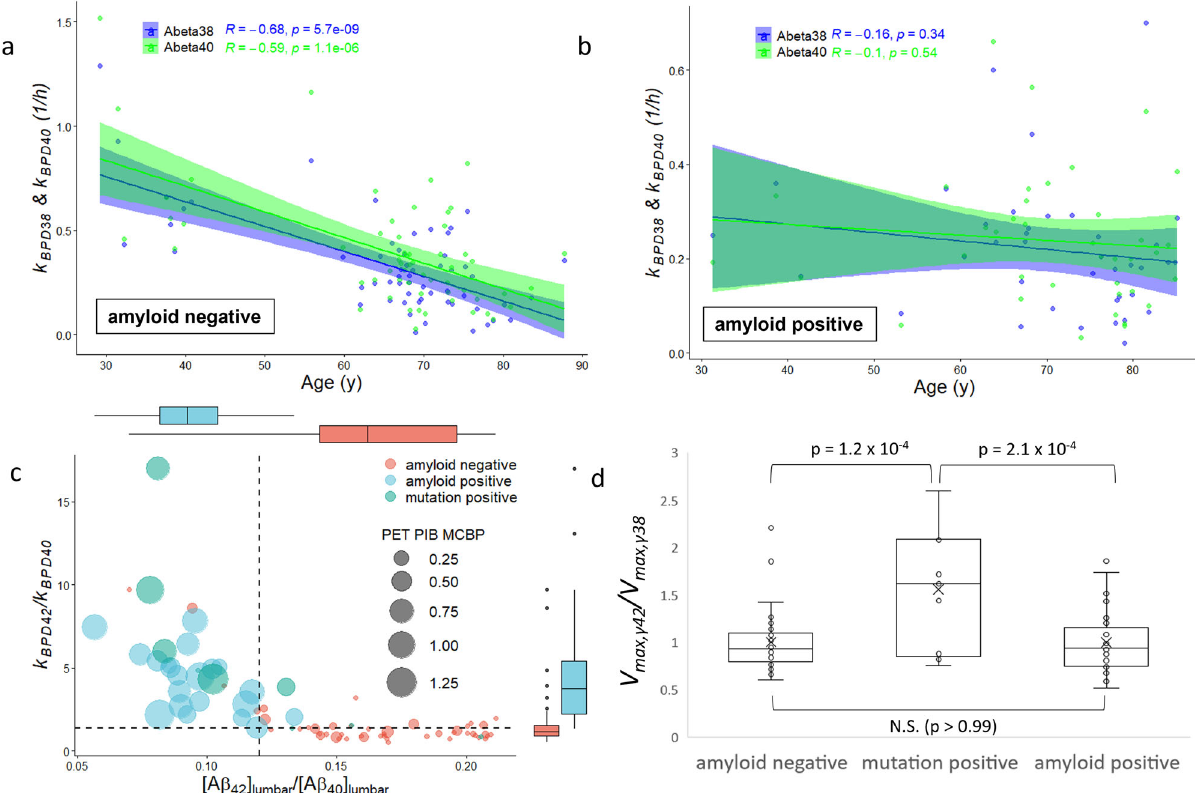
Fig. 4 Derived A β production and clearance rate constants. A β clearance and production rate constants. a The rate constant describing the irreversible loss of A β peptides from the brain ISF compartment ( k BPD ) signi fi cantly declined with age in amyloid-negative subjects for A β 38 and A β 40 ( n = 58; also see Table 1). b The age effect on k BPD38 and k BPD40 was absent in amyloid-positive subjects ( n = 38). c The rate of irreversible loss of A β 42 ( k BPD42 ) was elevated relative to A β 40 ( k BPD40 ) in the presence of amyloid plaques, as evidenced by elevated PET PIB MCBP ( n = 77). This elevation likely represented active deposition of A β 42 into plaques, and a cutoff of 1.3 (horizontal dashed line) distinguishes most plaque-bearing subjects from non-plaque-bearing subjects. Declining ratios of lumbar CSF A β 42 to A β 40 are a hallmark of AD, with a cutoff of 0.12 in common use (vertical dashed line). See statistical comparisons in Table 1. d The gamma-secretase production rate constant ratio V max, γ 42 / V max, γ 38 re fl ects the kinetics of gamma-secretase toward the production of A β 42 relative to A β 38 . The production rate ratio did not differ by amyloid status, but presenilin mutation carriers had elevated production of A β 42 relative to A β 38 as compared to both groups of non-mutation carriers. ANOVA with Tukey post hoc analysis. Table 2 Production rates in presenilin mutation carriers and age-matched